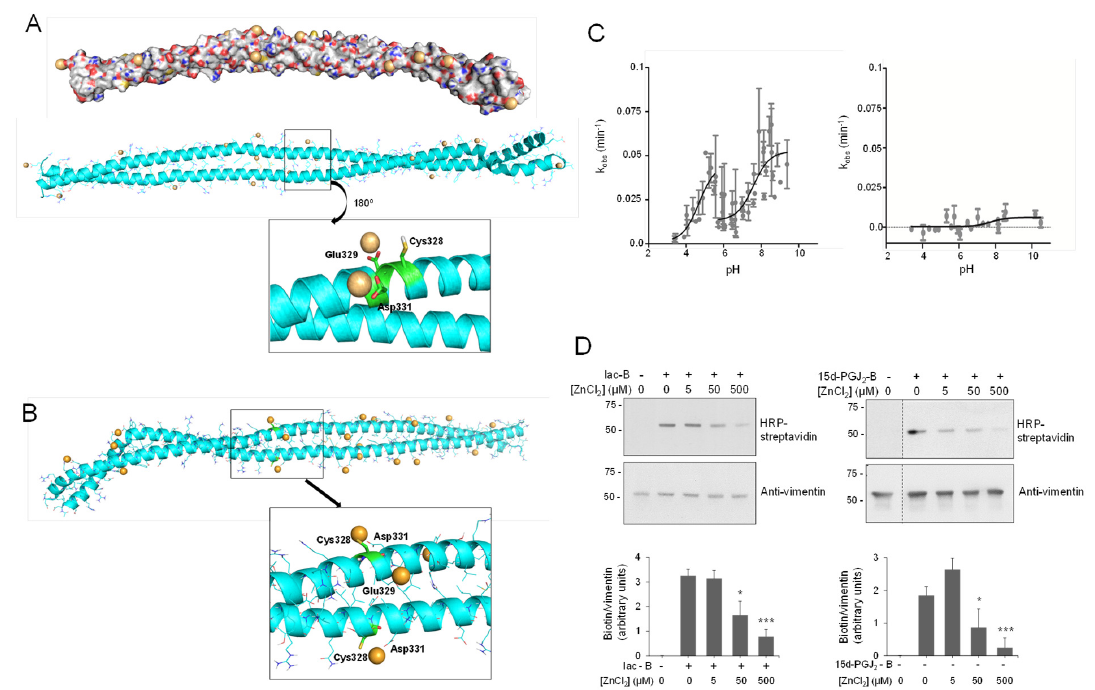
Figure 2. Vimentin dimer and its interaction with zinc. ( A ) Zinc binding at vimentin B dimer. Filled and ribbon views of dimer B are shown. After 100 ns MD simulation, zinc atoms, shown as orange spheres, were placed in electronegative regions. Below, the region near Cys328 is displayed in detail, illustrating the interaction of zinc atoms with Glu329 and Asp331. After 30 ns of MD simulation, two zinc atoms remained close to Cys328, interacting with Glu329 and Asp331 during the whole simulation time. ( B ) Zinc binding at vimentin B dimer, with Cys328 in its thiolate form. In this case, the cysteine interacts directly with zinc atoms, as displayed in the detailed view. ( C ) Experimental determination of vimentin Cys328 pK a . Kinetics of MBB modification of vimentin wild type (wt, left panel) and Cys328Ser mutant (right panel) were measured at different pHs in triplicate using a Varioskan plate reader and the k obs calculated for each case. The pK a was obtained from the representation of k obs values against the final pH of the reaction. ( D ) Protection of vimentin modification by zinc. Purified vimentin wt (4.3 μ M final concentration) was incubated with ZnCl 2 at the indicated concentrations for 1 h at r.t., before adding vehicle, biotinylated iodoacetamide (10 μ M, Iac-B, left panel), or biotinylated 15d-PGJ 2 (1 μ M, 15d-PGJ 2 -B, right panel), and incubating an additional hour at 37 °C. Incubation mixtures were run on SDS-PAGE gels, electro-blotted, and incorporation of the biotinylated compounds assessed by biotin detection with HRP-conjugated streptavidin. Vimentin was detected by western blot. Dotted lines indicate where lanes from the same gel have been cropped. The position of molecular weight standards (in kDa) is indicated on the left. The ratio of the biotin and the vimentin signals is displayed in the graph as mean values ± SEM of four independent assays. * p < 0.05 vs. Iac-B or 15d-PGJ 2 -B at 0 μ M ZnCl 2 ; *** p < 0.0005 vs. Iac-B or 15d-PGJ 2 -B at 0 μ M ZnCl 2 by Student’s t -test.